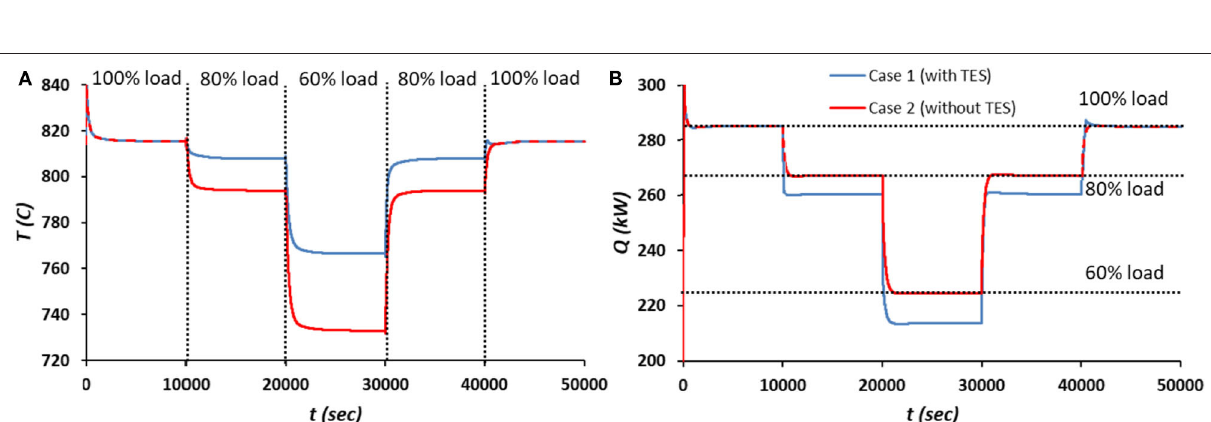
heat transfer rates that help in the speed-up of load